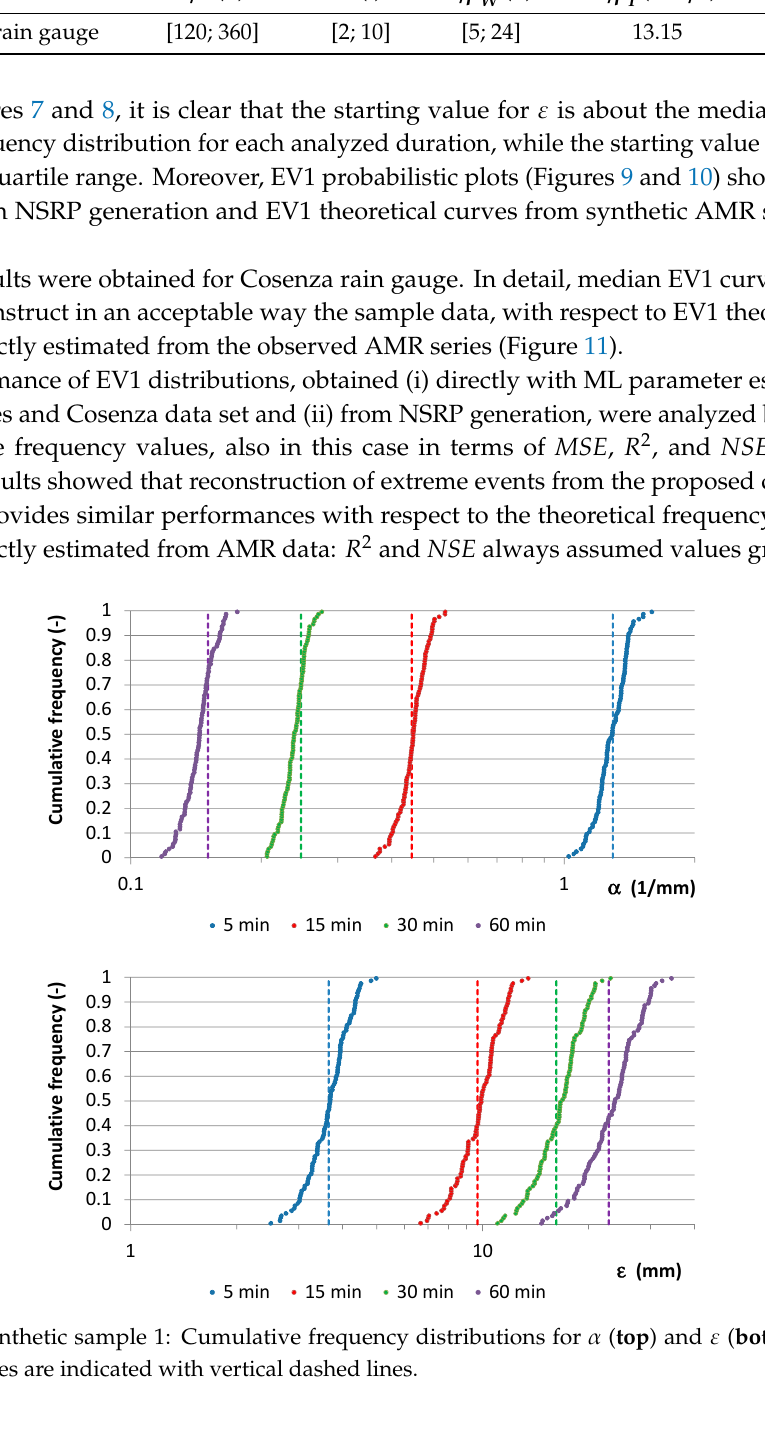
Figure 7. Synthetic sample 1: Cumulative frequency distributions for α ( top ) and ε ( bottom ). The starting values are indicated with vertical dashed lines.